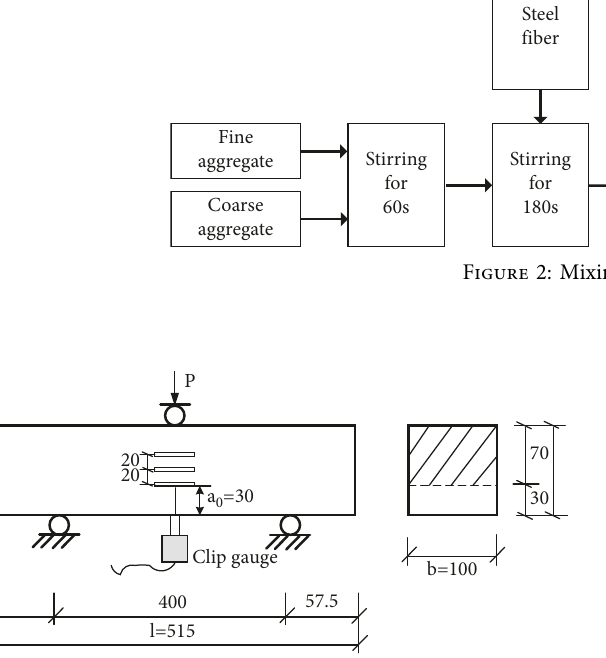
Figure 3: Three-point bending fracture test